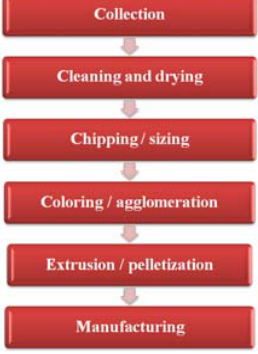
Figure 2. The steps involved in mechanical recycling.